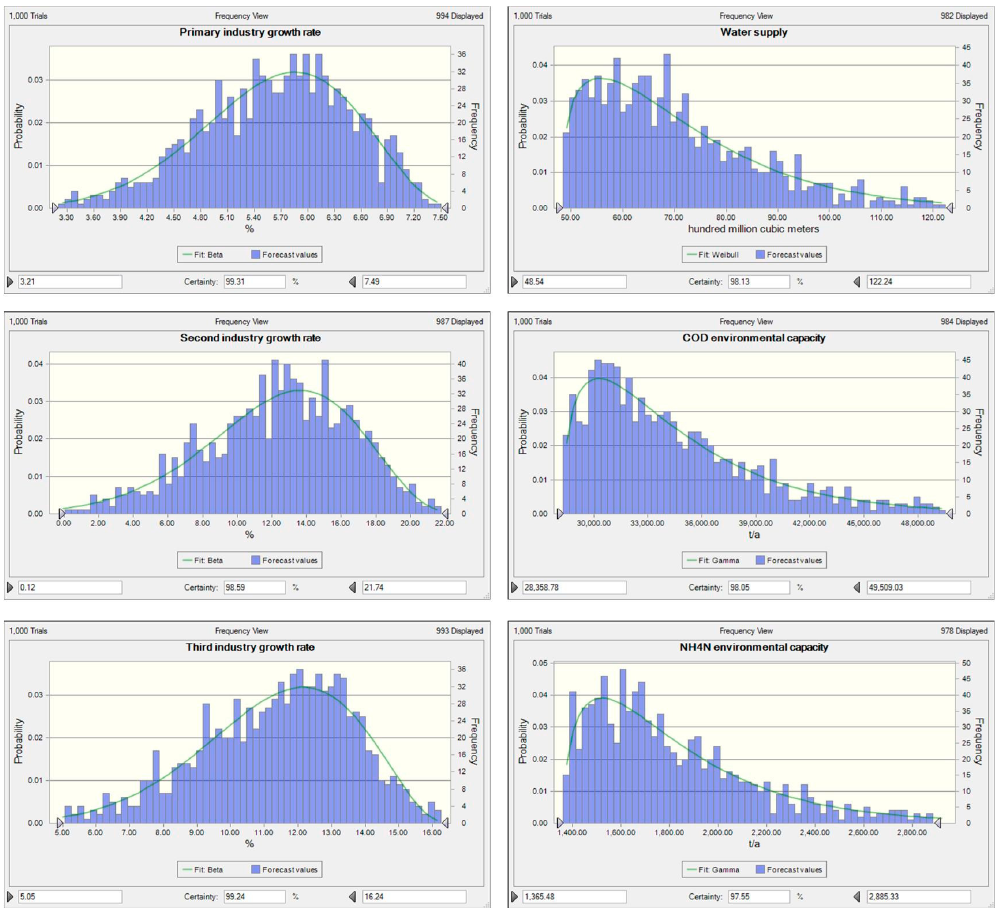
Figure 6. Probability distribution characteristics of six indicators. The probability of any interval within distribution range of each index can be obtained.